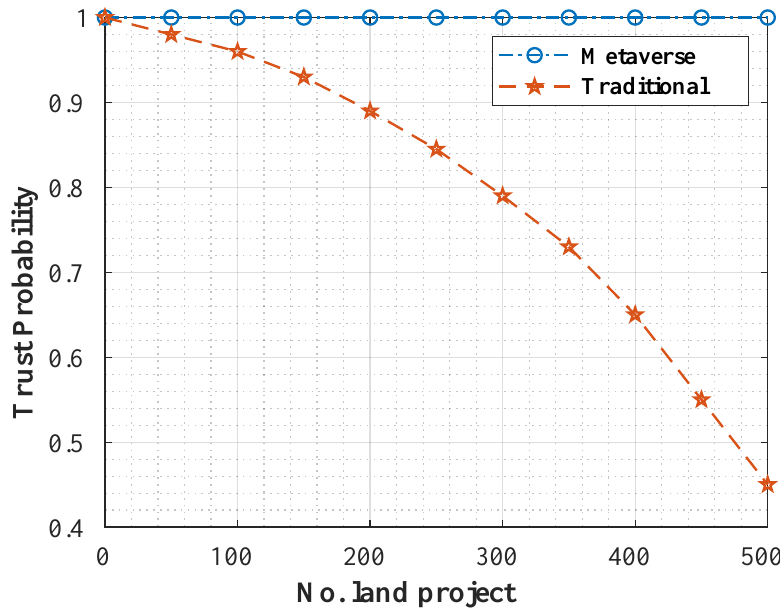
Figure 10. Trust probability on the number of land transactions.